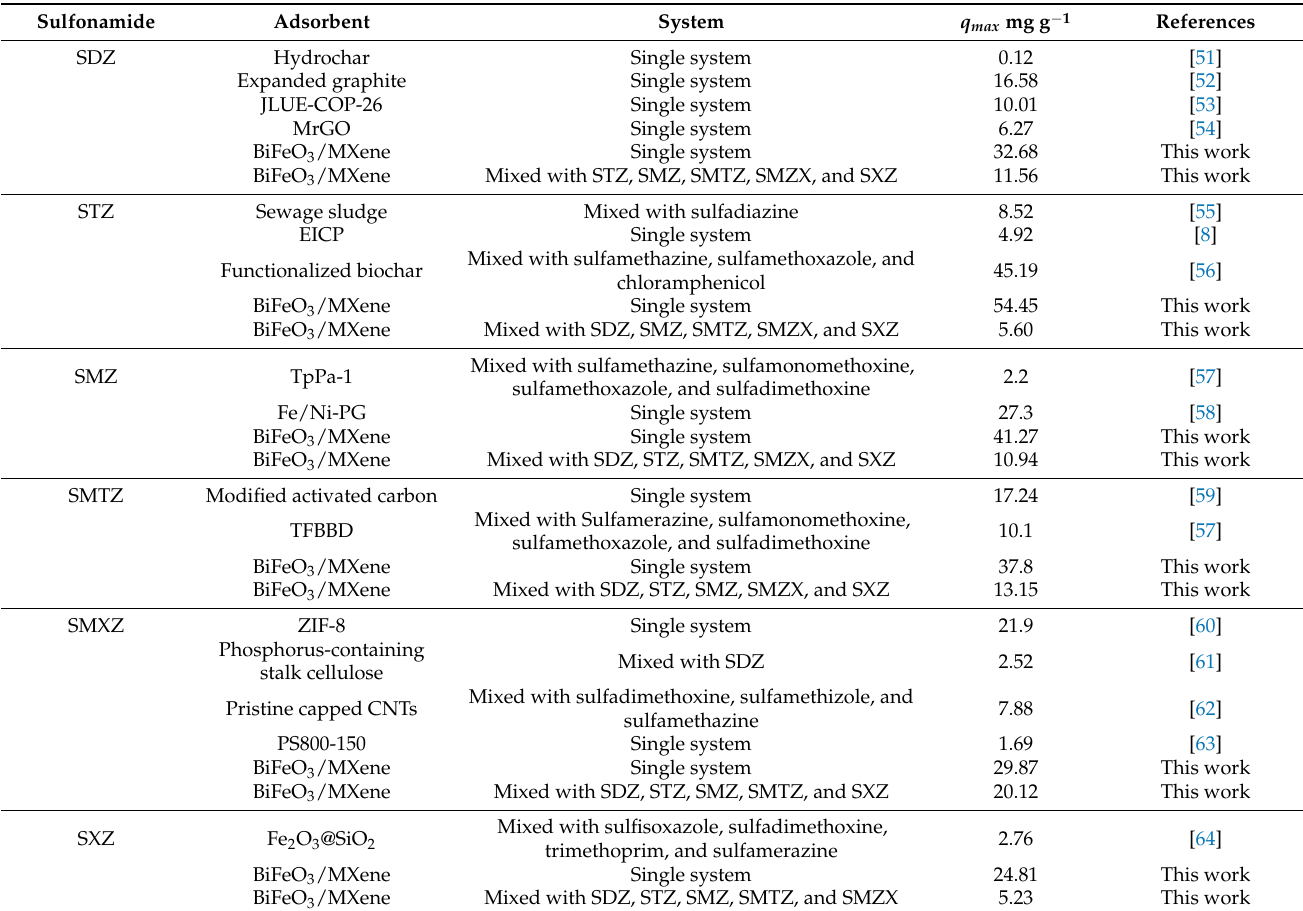
Table 3. The comparison of maximum adsorption capacities of various adsorbents for sul- fonamides adsorption. Benzene-1,3,5-tricarbohydrazide reacted with benzidine (JLUE-COP-26), magnetic-reduced graphene oxide (MrGO), enzyme-induced carbonate precipitation (EICP), Tri- formylphloroglucinol p-Phenylenediamine (TpPa-1), 1,3,5-triformylbenzene-Benzidine